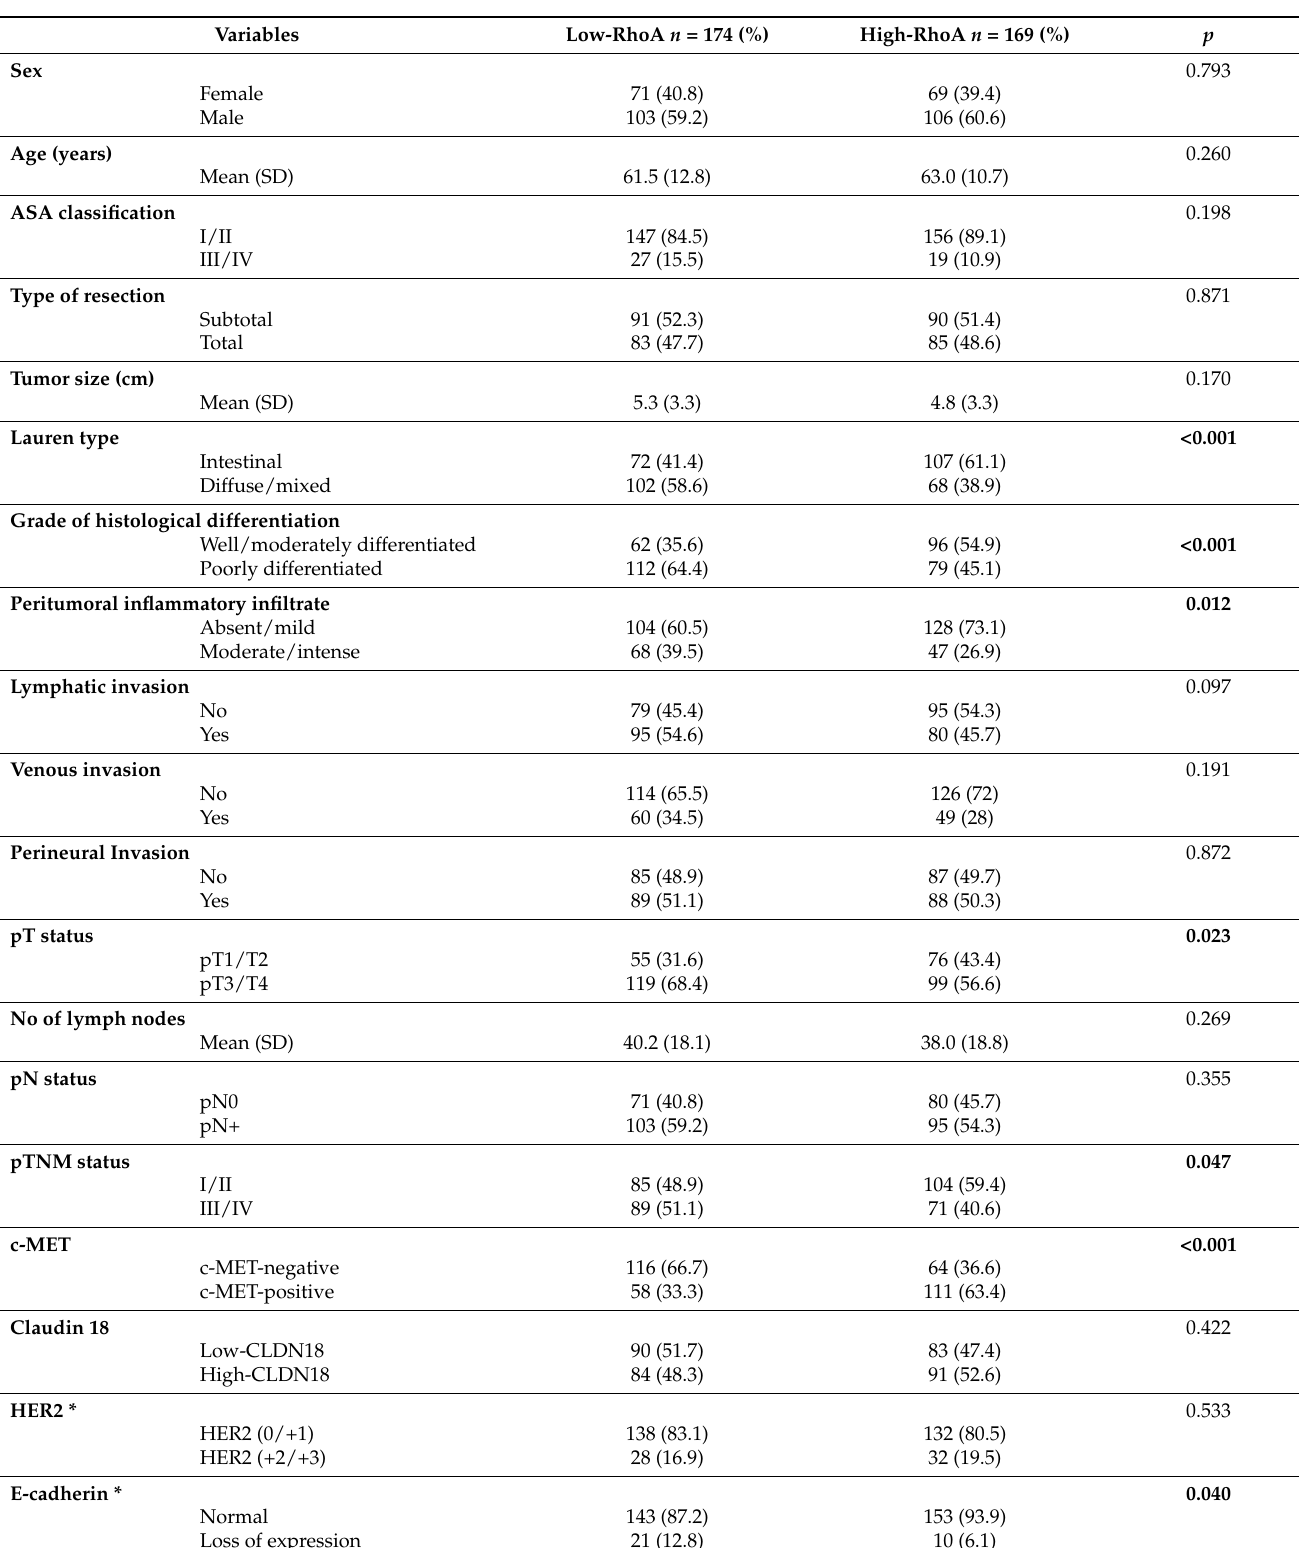
Table 2. Clinicopathological characteristics of gastric cancer patients according to the RhoA